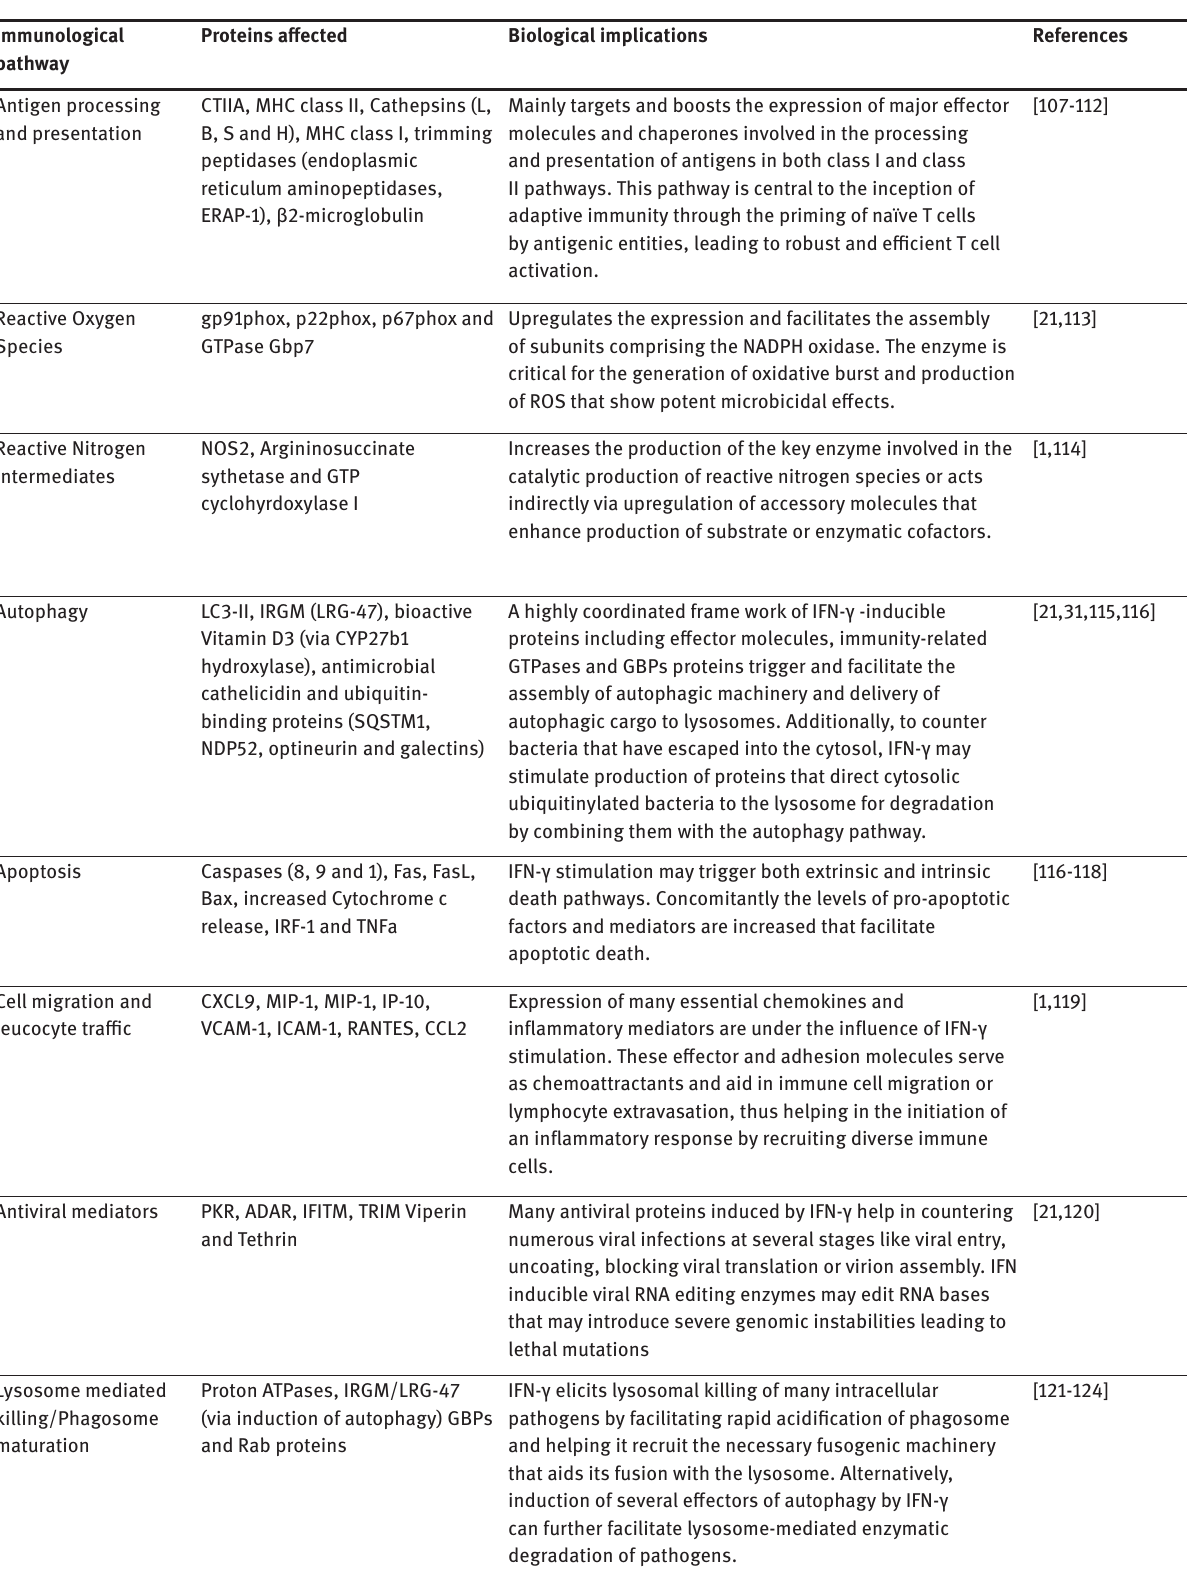
Table 1: Biological functions of IFN-γ: An